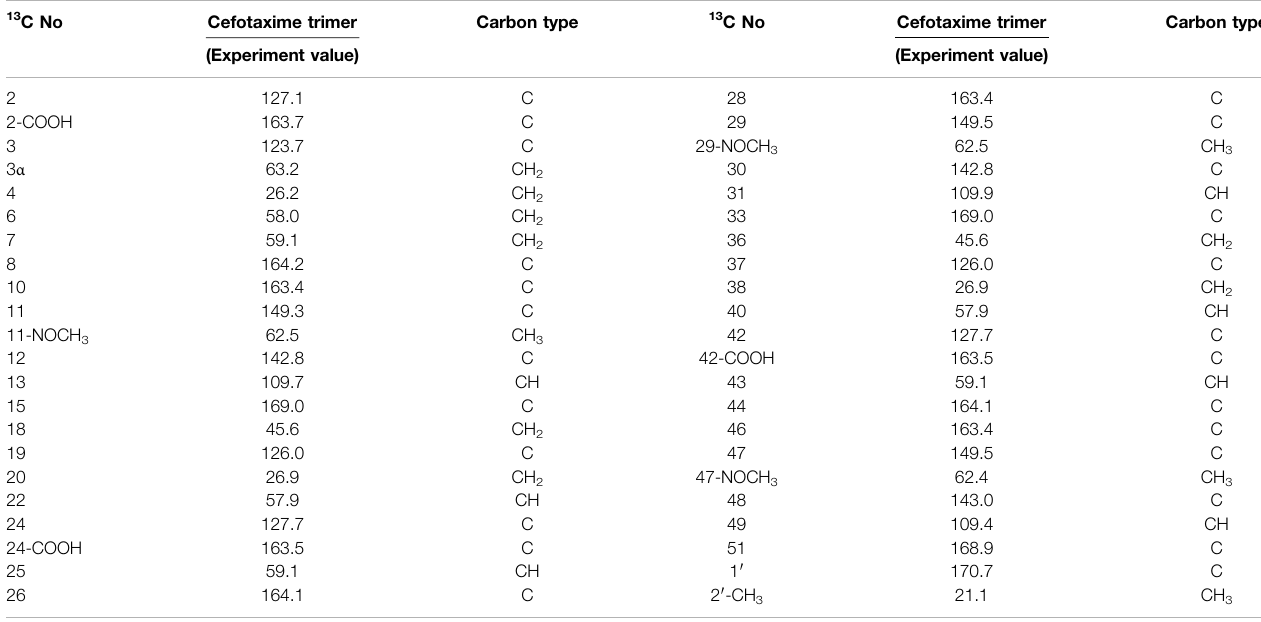
TABLE 5 | 13 C-NMR and APT spectra of cefotaxime and cefotaxime